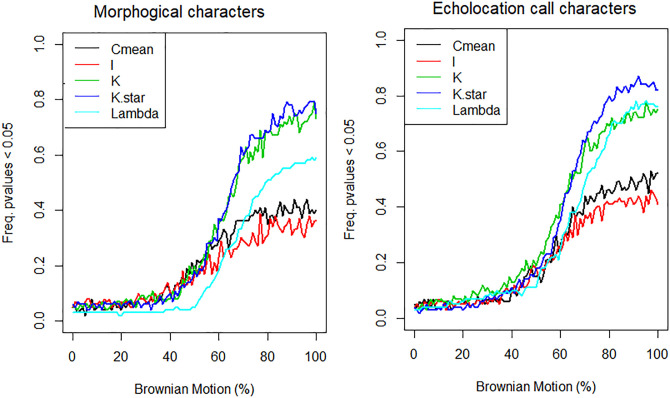
Plots of morphological and echolocation call characters showing the frequency of p values < 0.05 in five indices (Blomberg’s K and K*, Abouheif’s Cmean, Moran’s I, and Pagel’s Lambda) according to the proportion of Brownian Motion in the phylogeny of Molossus.